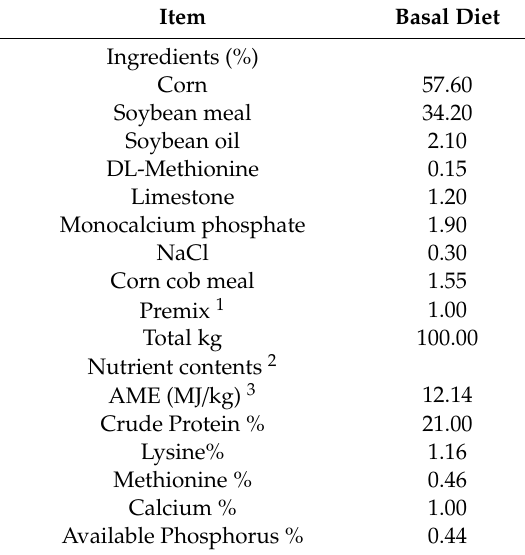
Table 1. Composition and nutrient levels of the experimental diets (air-dry basis, %) of yellow-feathered chickens aged 4 to 24